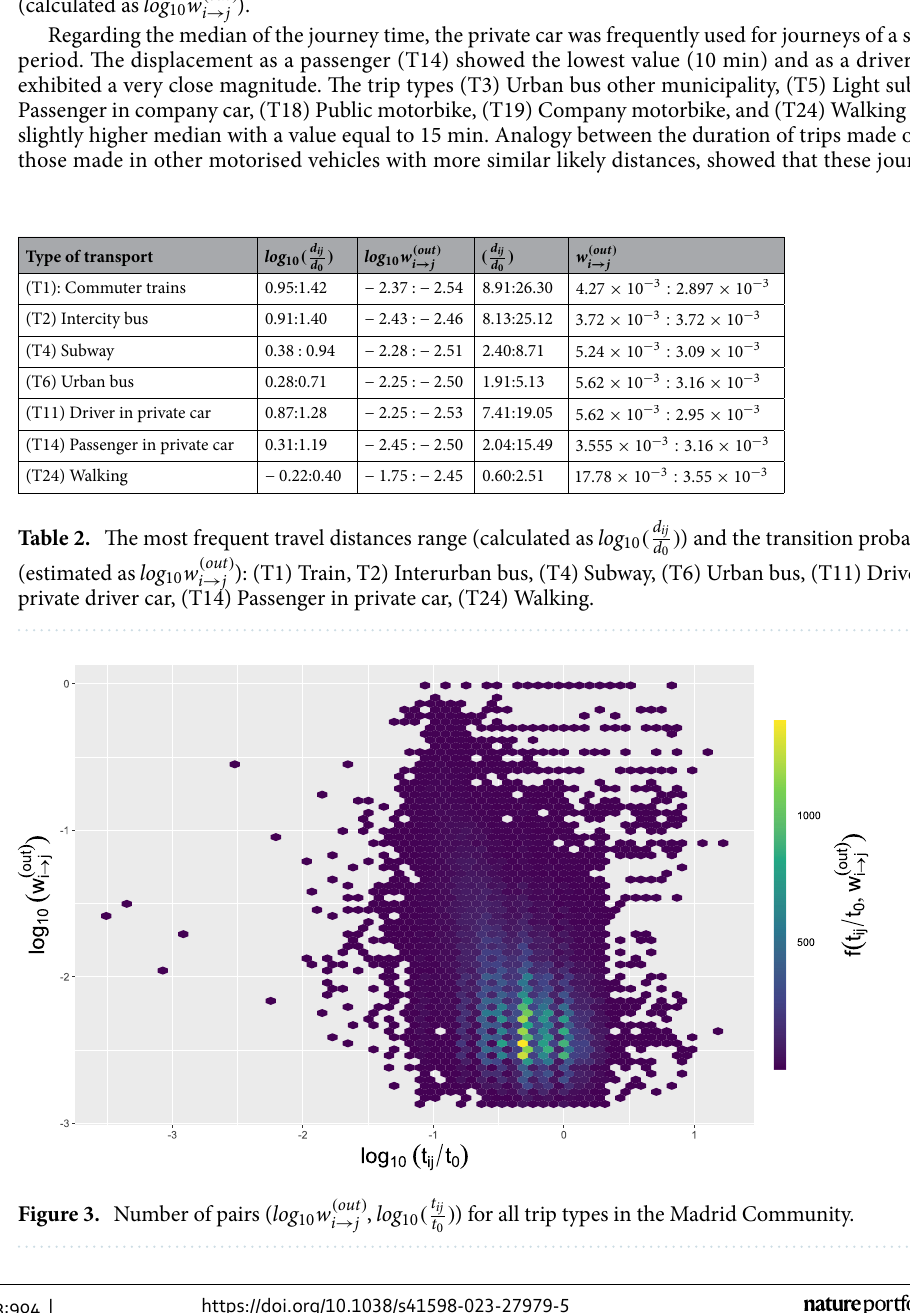
Figure 3. Number of pairs ( log 10 w